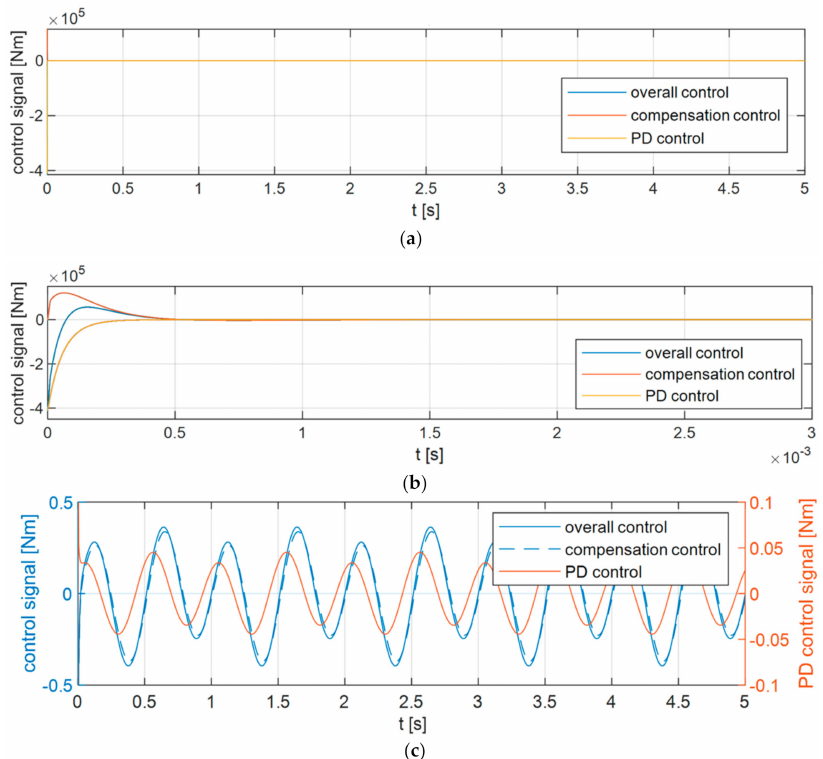
Figure 6. Control signals: ( a ) overall control system and control signal components; ( b ) control during the initial phase of gait; ( c ) control graph with customized